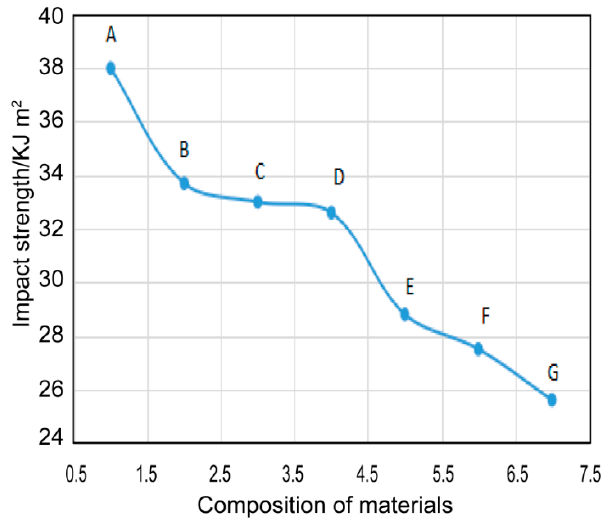
Figure 11. The impact strength curves of the different EP-POSS systems. Table 2. The mechanical properties of the different EP-POSS systems.